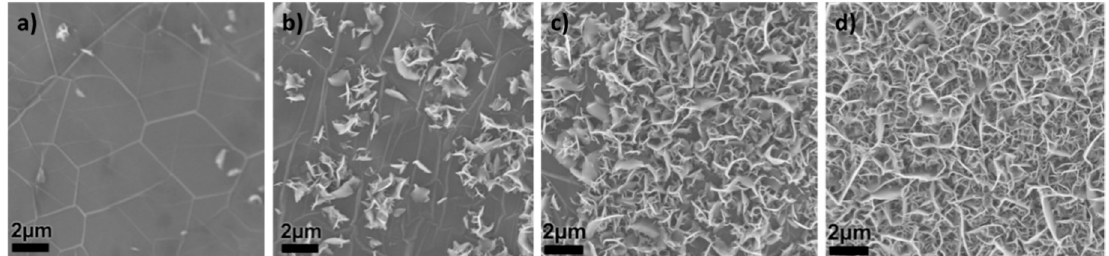
Figure 2. SEM images showing the surface evolution during VG deposition that suggest the three major steps of VG growth process: ( a ) the 1 st minute, ( b,c ) in the following several minutes, and ( d ) after 15 minutes. Reproduced with permission from Ref. [42], Copyright 2016, Elsevier.